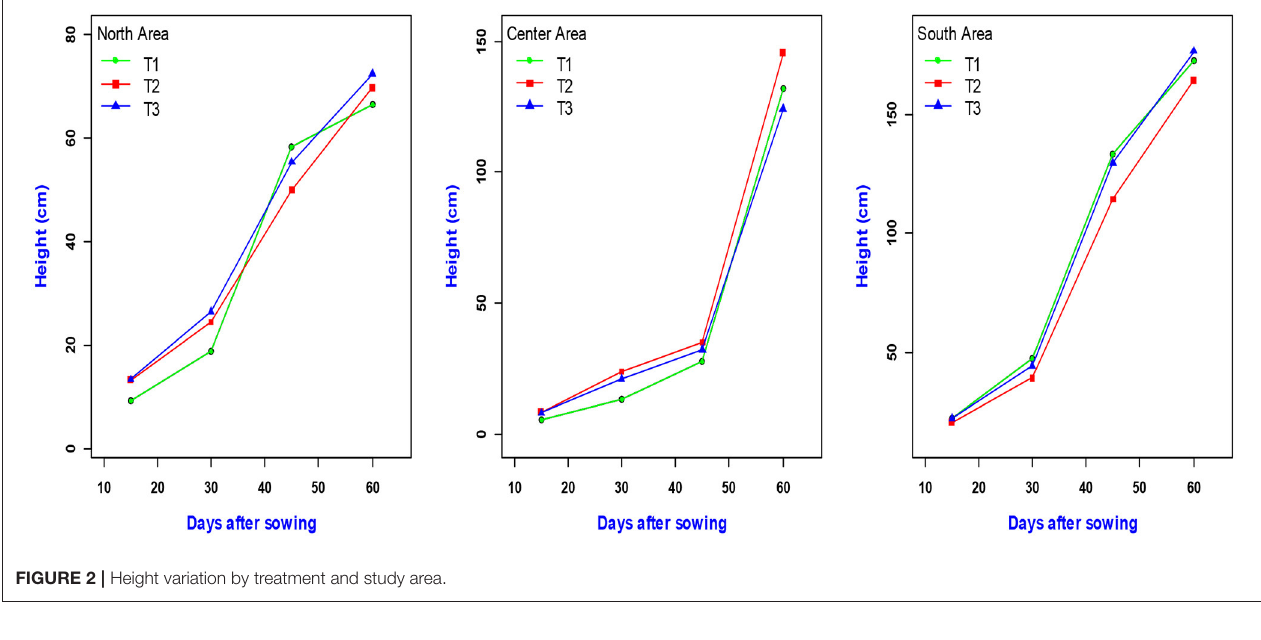
FIGURE 2 | Height variation by treatment and study area.